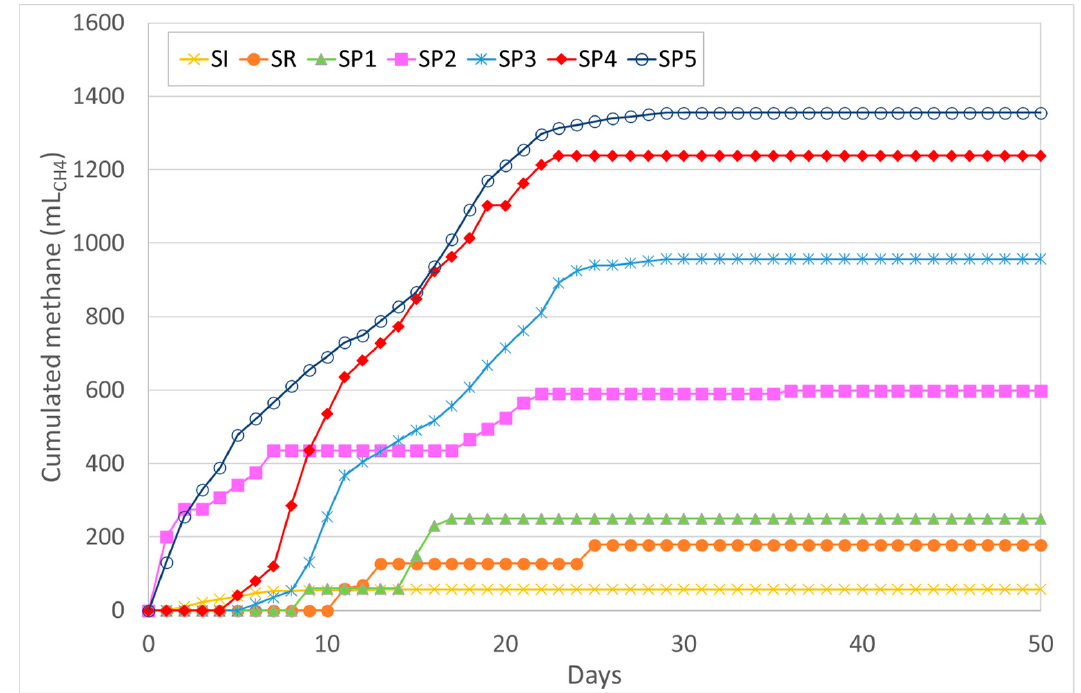
Figure 4. Cumulated methane volumes detected during the BMP tests.